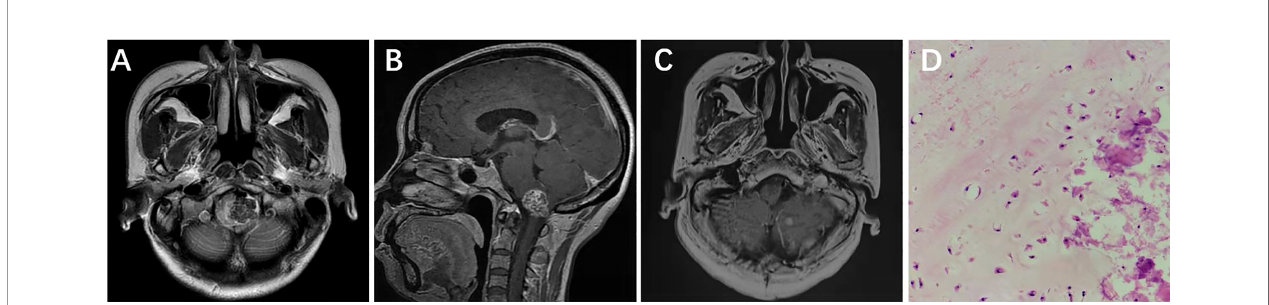
FIGURE 2 | Left side of the medulla oblongata showed a round mixed short T2 signal shadow within which speckled long T2 signal was seen (A) . Sagittal contrast- enhanced MRI showed that medulla oblongata was compressed by confounding signal mass located in foramen magnum (B) . Six months after surgery, enhanced MRI showed that the tumor had not recurred (C) . Pathological results at 200× magni fi cation showed mature chondrocytes of different sizes and vacuolar formation in some cells